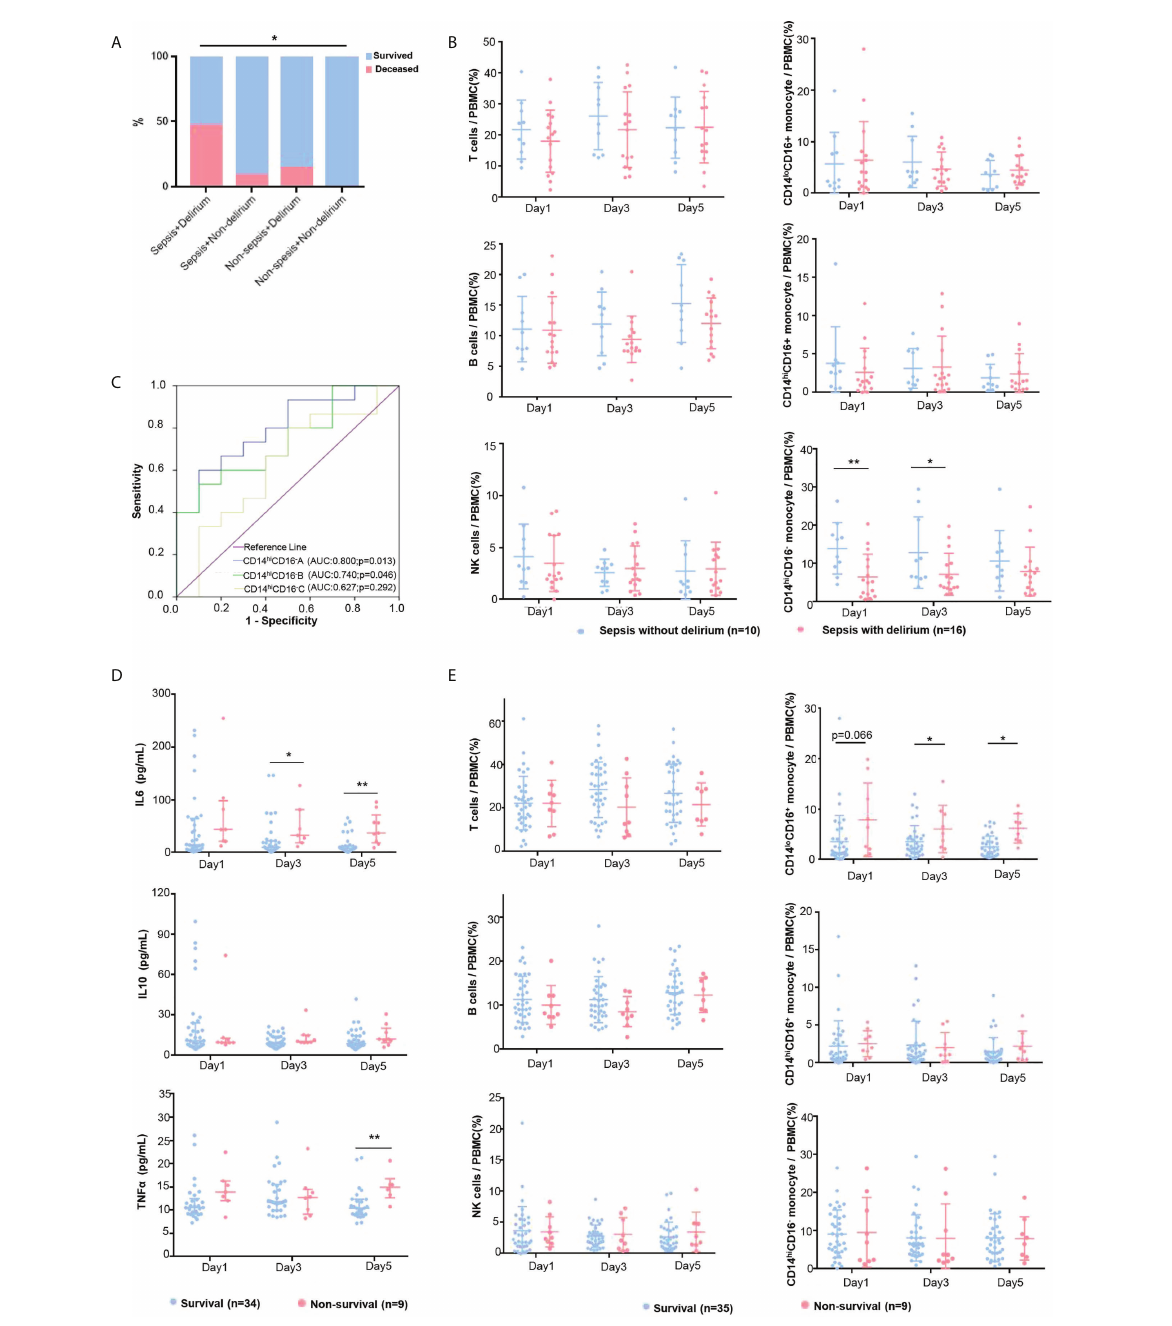
FIGURE 1 Peripheral immune pro fi ling of critical patients. (A) Survival rate of eligible ICU patients of examinational cohort. The mortality rates of four groups were compared using Pearson ’ s chi-square test. (B) The immune cell proportions in patients with SAD and patients with sepsis were compared at days 1, 3, and 5. The patients with SAD (red dots) and sepsis patients without delirium (blue dots) were compared by t -test. Plots show mean and SD. (C) ROC curves for CD14 hi CD16 - monocytes at days 1, 3, and 5 for predicting the incidence of delirium in sepsis patients. (D) The levels of plasma cytokines were tested in nonsurvival and survival groups with ELISA at days 1, 3, and 5. The 28-day survivors (blue dots) and nonsurvivors (red dot) were compared by the nonparametric Mann – Whitney U test. Plots show median and IQR. (E) Immune cell proportions in 28-day nonsurvivors and survivors were compared on admission days 1, 3, and 5. The 28-day survivors (blue dots) and nonsurvivors (red dots) were compared by t -test. Plots show mean and SD. * refers to p <.05, and ** refers to p